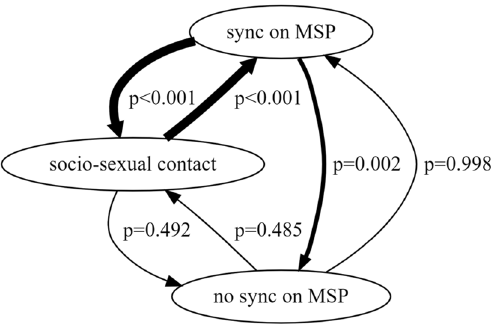
Figure 6. The flow diagram—generated by Behatrix 0.9.11—representing the transitions and their probability between synchronization and no-synchronization on MSP and socio-sexual contacts. Thick arrows indicate significant transitions (socio-sexual contacts → synchronization on MSP: p < 0.001; synchronization on MSP → socio-sexual contacts: p < 0.001; synchronization on MSP → no-synchronization on MSP: p =